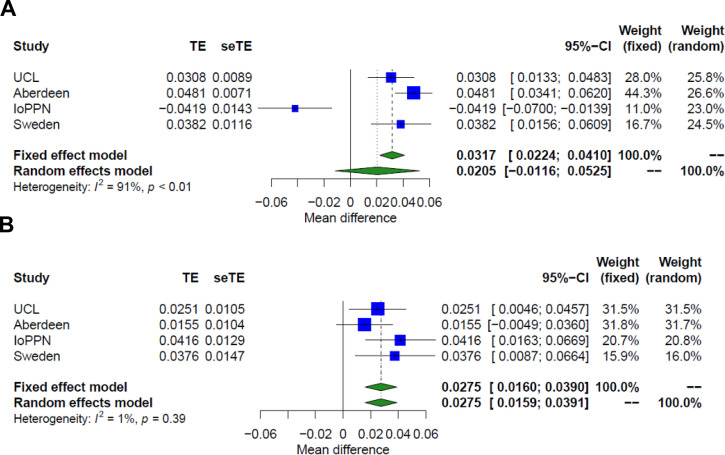
Additive effect of schizophrenia and treatment resistance on granulocyte proportions.Shown are forest plots from meta-analyses of differences in estimated granulocyte proportions derived from DNA methylation data between (A) schizophrenia patients and controls and (B) treatment-resistant schizophrenia patients prescribed clozapine, and schizophrenia patients prescribed other medications. TE: treatment effect (i.e., the mean difference between cases and controls); seTE: standard error of the treatment effect.